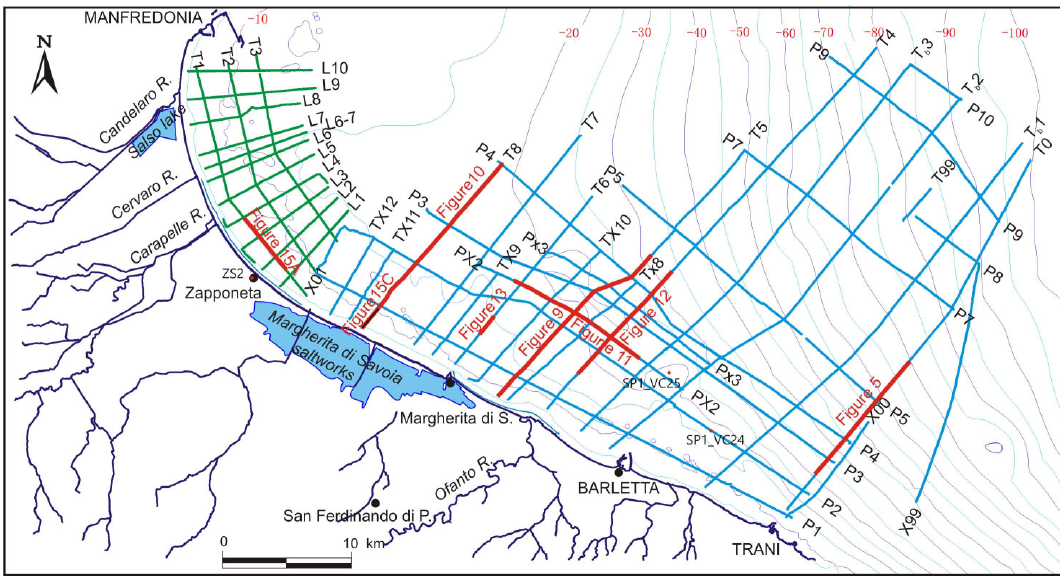
Figure 2. Study area with seismic profiles acquired in the two surveys: in green colour those of the 2013–2014, in blue colour those of the 2016–2017; the red parts of the seismic profiles correspond to the sections reported in the figures indicated. The black part in seismic profile T8 is reported in Figure 13C. Contour line of the present sea bottom and positions of ZS2 borehole and SP1_VC24 and SP1_VC25 vibro-cores are also shown. The abbreviations of seismic profiles are shown at their ends.